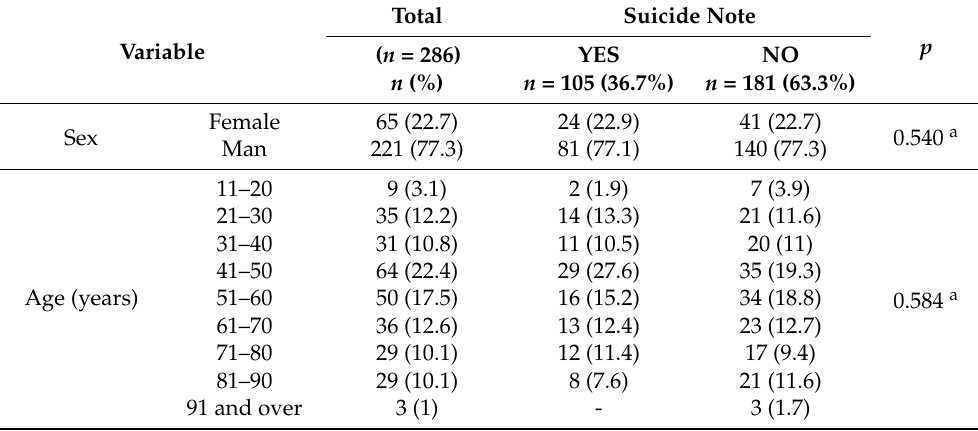
Table 1. Description of cases with and without a suicide note according to sociodemographic